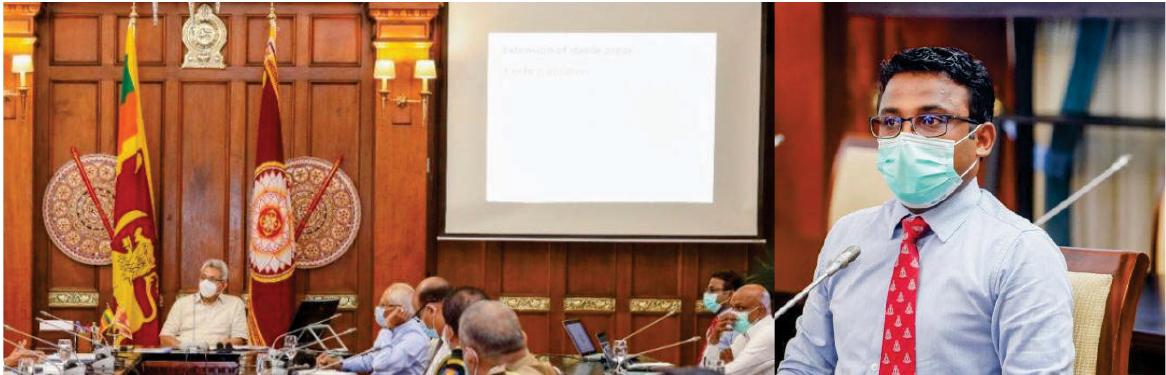
Figure 1: Exit Strategy presented to His Excellency the President